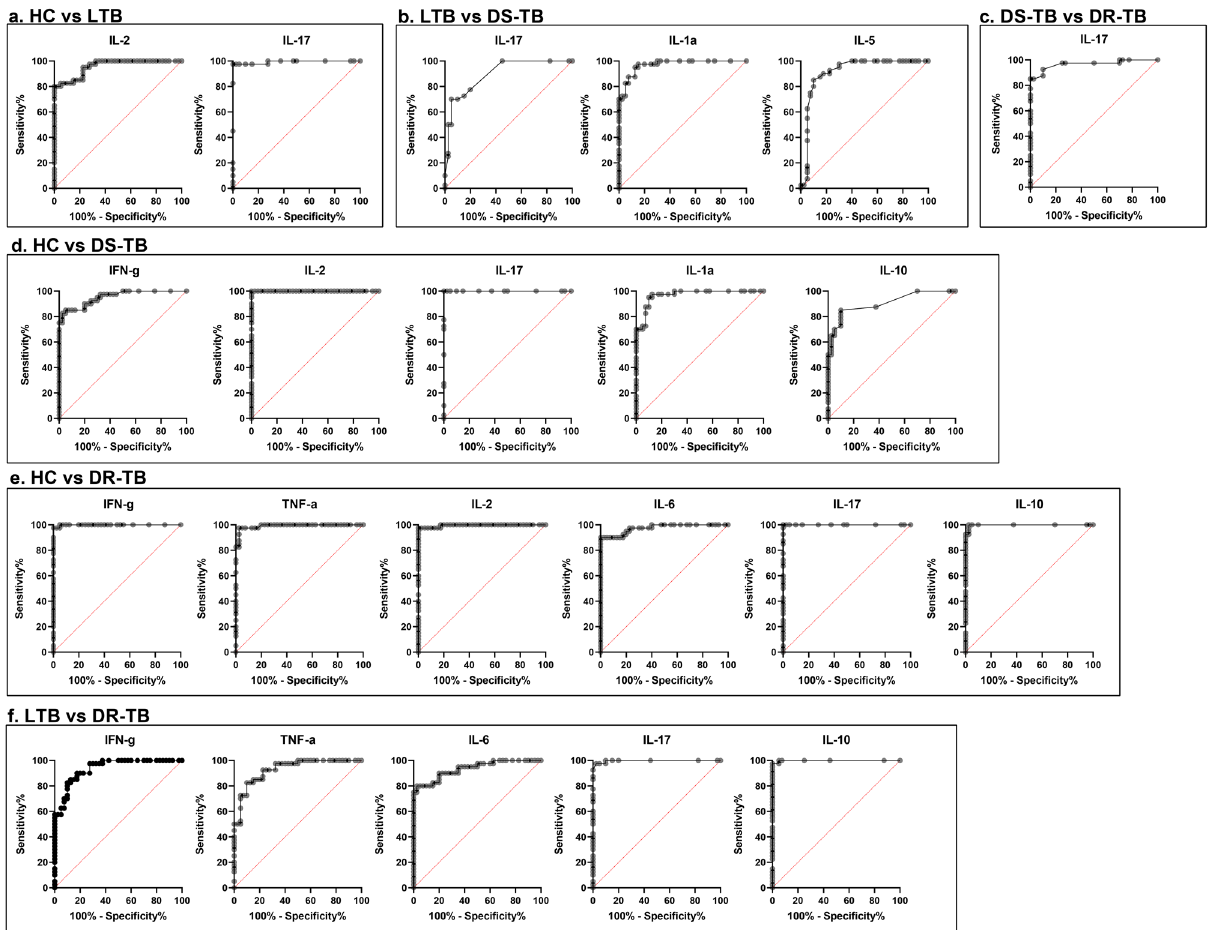
Figure 3. ROC curves of significant cytokines with AUC > 0.9 showing the diagnostic efficiency between the study groups, ( a ) HC vs LTB, ( b ) LTB vs DS-TB, ( c ) DS-TB vs DR-TB, ( d ) HC vs DS-TB, ( e ) HC vs DR-TB and ( f ) LTB vs